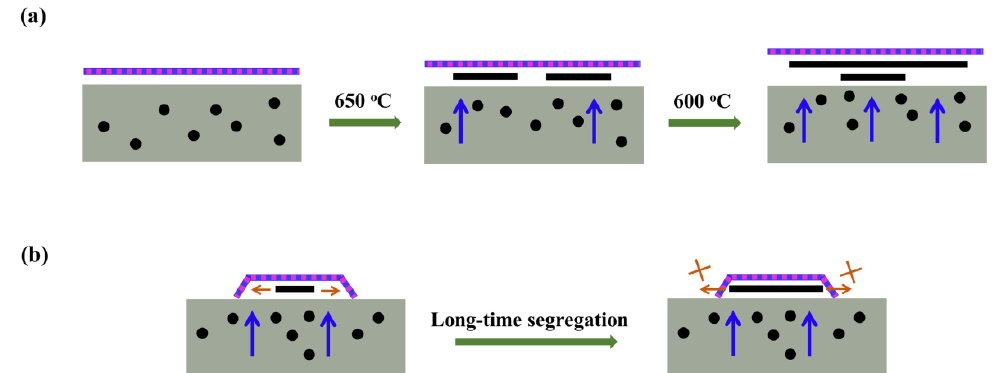
Figure S1: Initial XPEEM images at C 1s and N 1s core levels with binding energies of 285.1, 399.0, and 398.6 eV ( hv = 500 eV) at the surface segregation temperature of 650 ◦ C. Figure S2: Initial XPEEM images at C 1s core levels with binding energies of 285.1 and 284.5 eV, and N 1s core levels with binding energies of 398.6 and 397.9 eV at the surface segregation temperature of 600 ◦